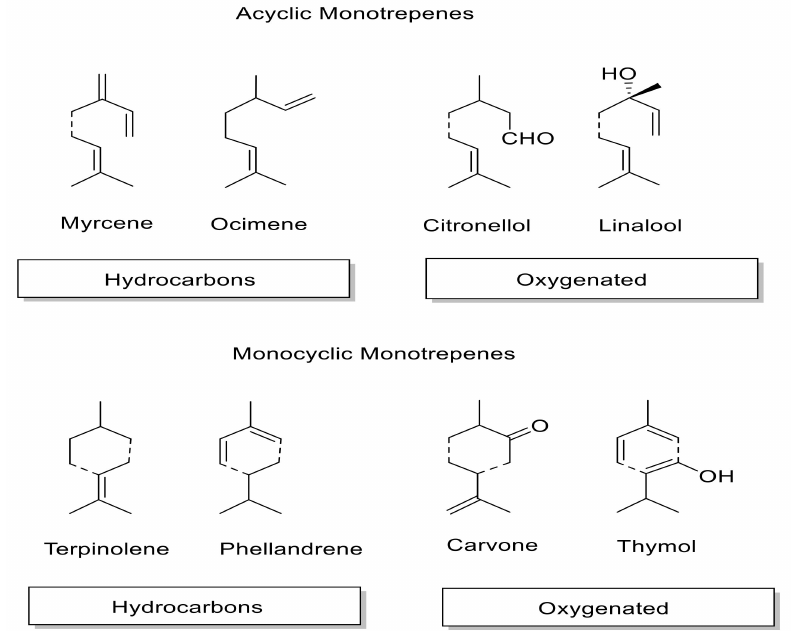
Figure 1. Main chemical classes and selected components found in essential